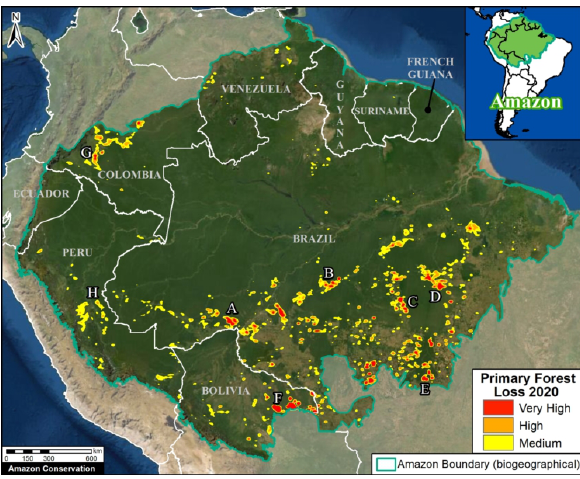
Figure 1: Hotspots of primary forest loss in Amazon in 2020 (Source: MAAP)